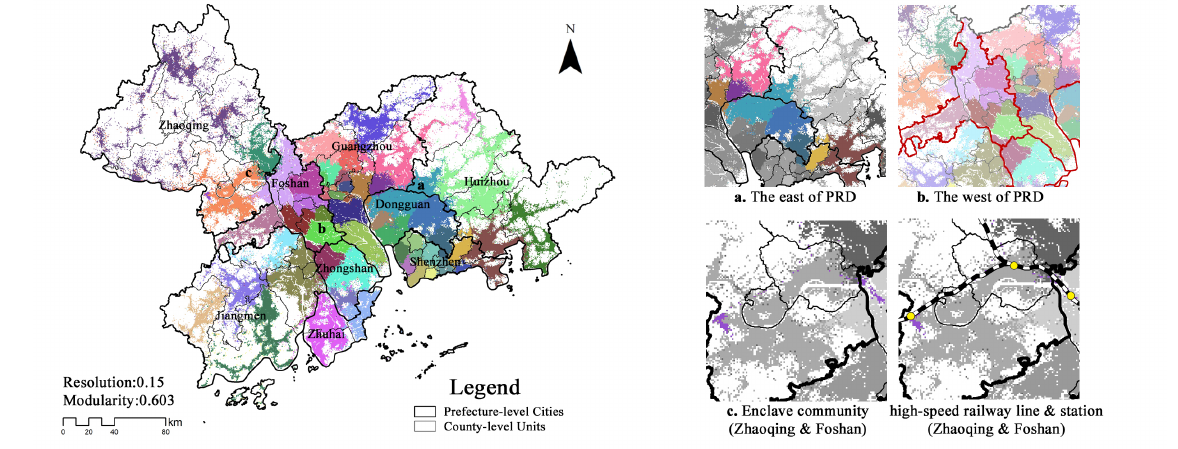
Figure 5. Detected communities in the